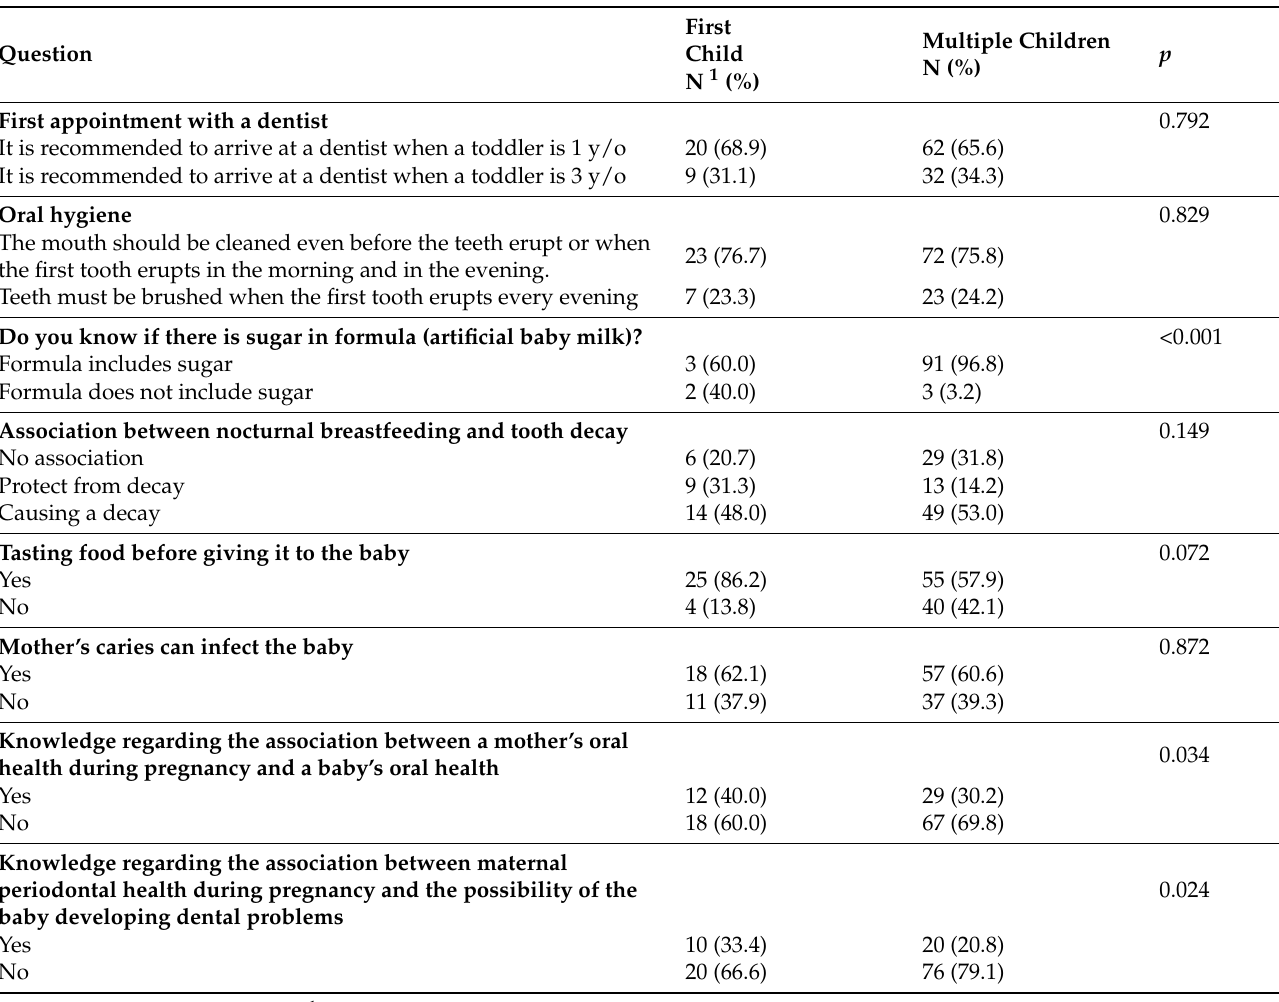
Table 3. Comparison between mothers with one child vs. multiple children in knowledge about the prevention and health of their toddlers’